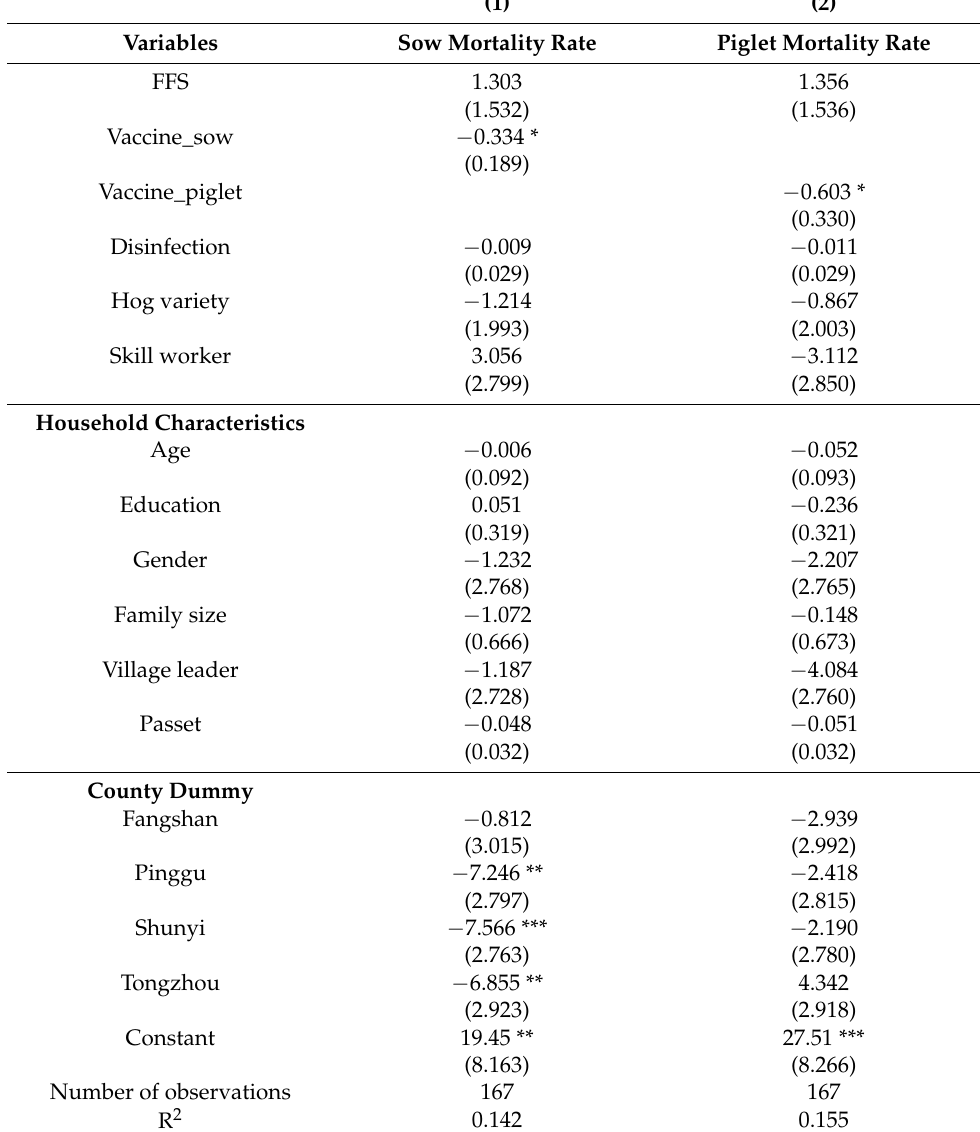
Table 5. Estimated impact of FFS on mortality rate of sow and